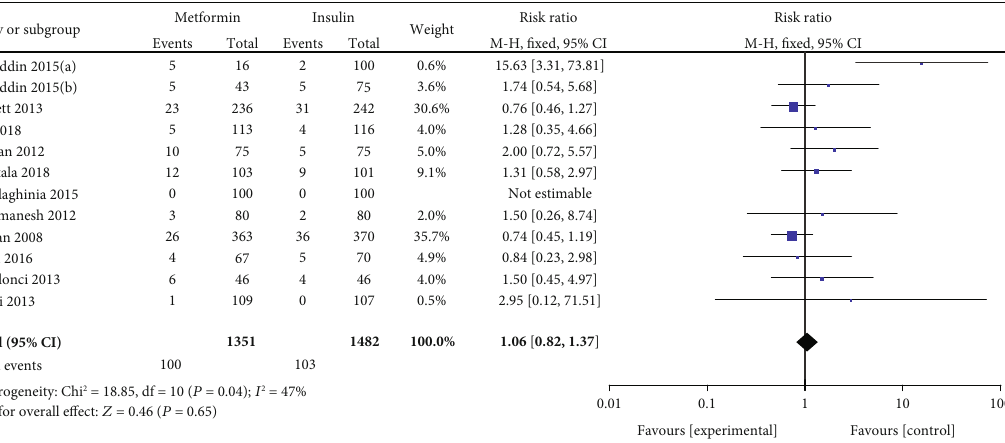
Figure 14: Small for gestational